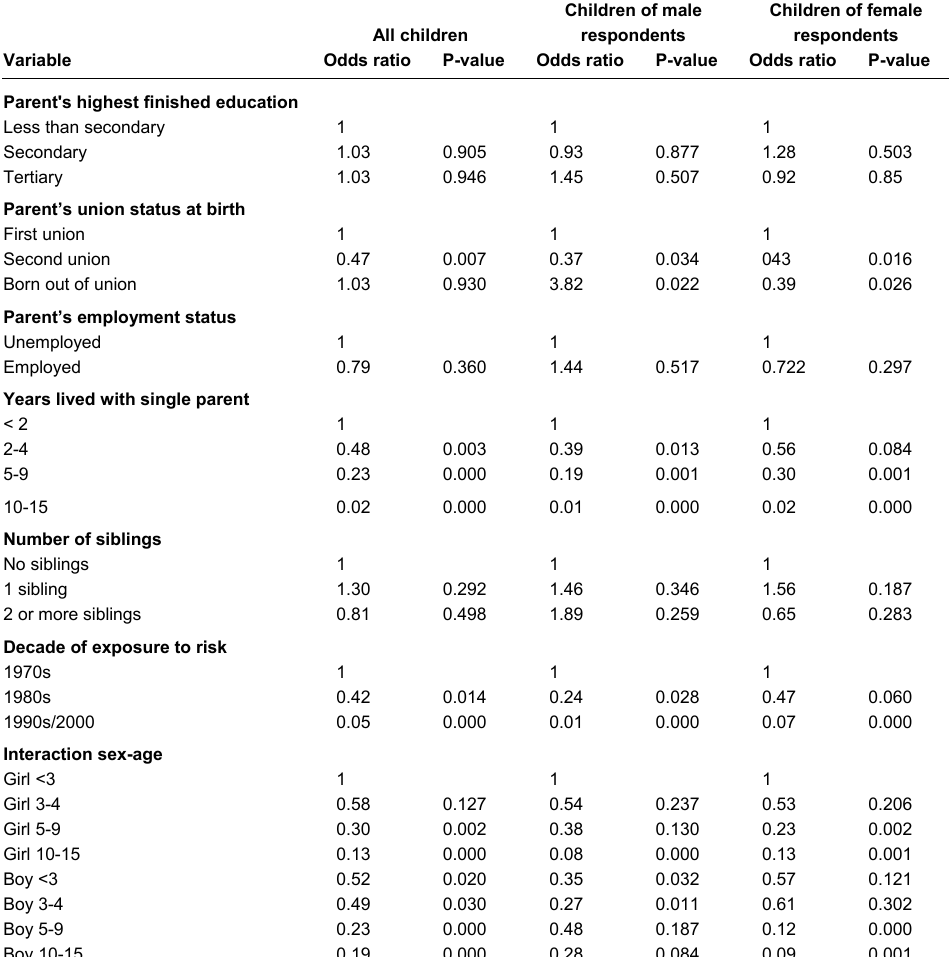
Table 3 : Relative odds of child entering a stepfamily.